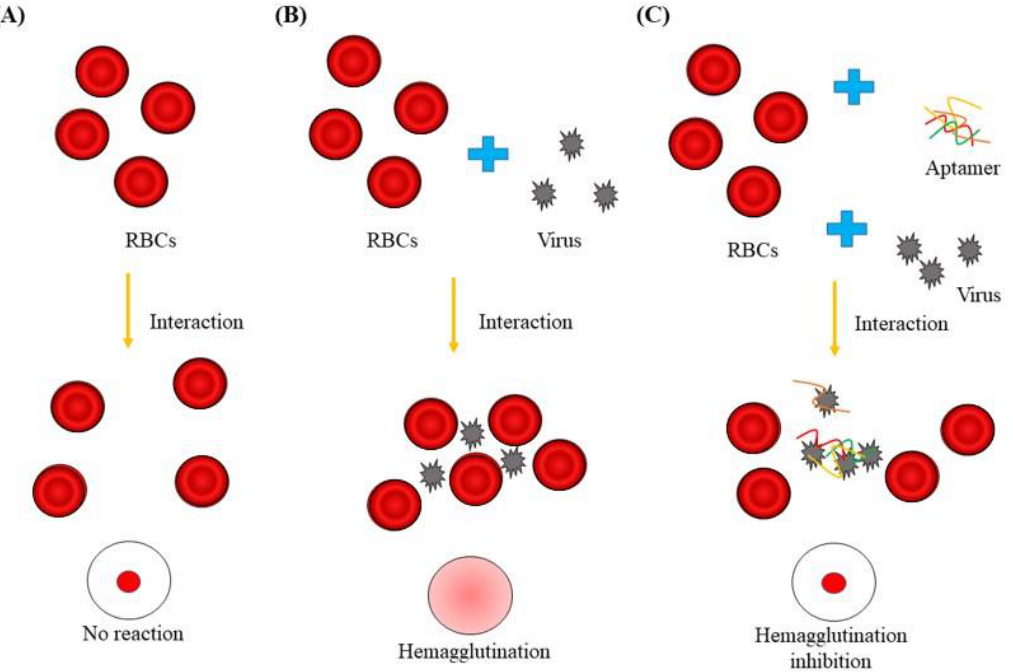
Figure 6. Schematic of the hemagglutination inhibition assay. ( A ) RBCs do not bind together and will sink to the bottom of the well plate. This is visible as a red dot at the center of the well. ( B ) A number of viruses have hemagglutinins that cause agglutination of RBCs, resulting in hemagglutination and formation of a lattice structure that results in a red color throughout the well. ( C ) Virus-specific aptamer, the virus, and the RBCs were added to the well plate. The virus-specific aptamer inhibits agglutination, which is visible as a red dot at the bottom of the well.